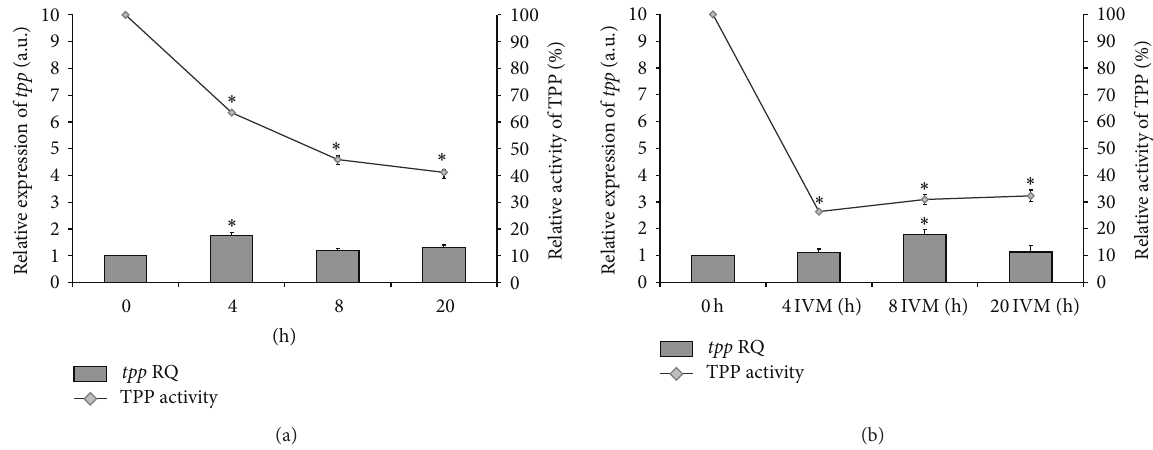
Figure 2: Relative activity of trehalose-6-phosphate phosphatase (TPP) and its mRNA ( tpp gene) expression normalized to the endogenous reference gapdh (glyceraldehyde-3-phosphate dehydrogenase) gene and relative to the expression at time zero (start group). IVM: ivermectin; RQ: relative quantification; (a) control group; (b) IVM-group; ∗ significant change at 𝑃 < 0.01 with respect to the start